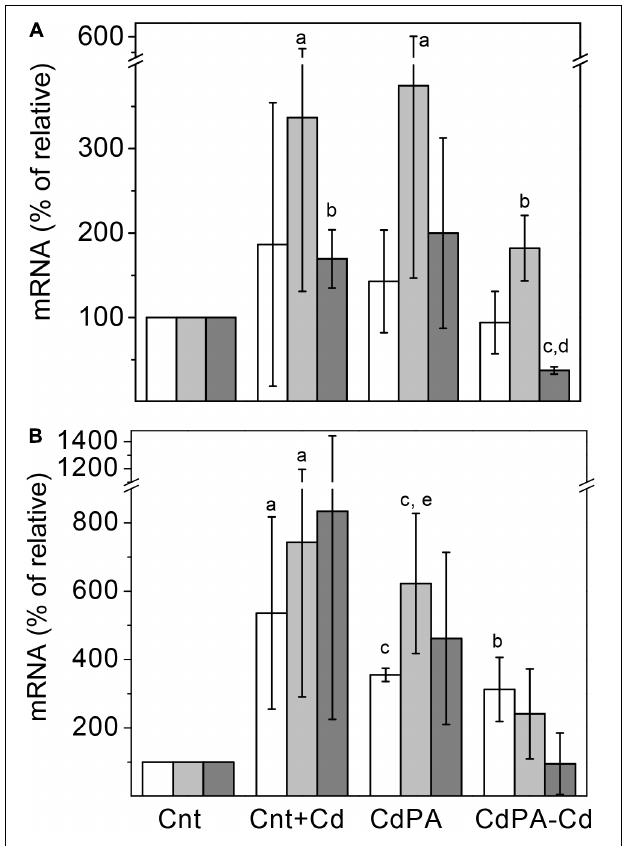
FIGURE 3 | Relative transcript contents of the ppx and ppk genes in Methanosarcina acetivorans. Transcript contents of the ppk (white bars), ppx (light gray bars) and pstA (gray bars) genes were determined in Cnt + Cd, CdPA and CdP-Cd cells and compared to control cells (Cnt), after 7 (A) and 14 (B) days of culture. Data shown are the mean ± SD of three independent experiments carried out by triplicate. a P < 0.05, b P < 0.01, c P < 0.001 vs. Cnt cells, d P < 0.01 vs. Cnt + Cd and CdPA, e P < 0.05 vs. CdPA-Cd.